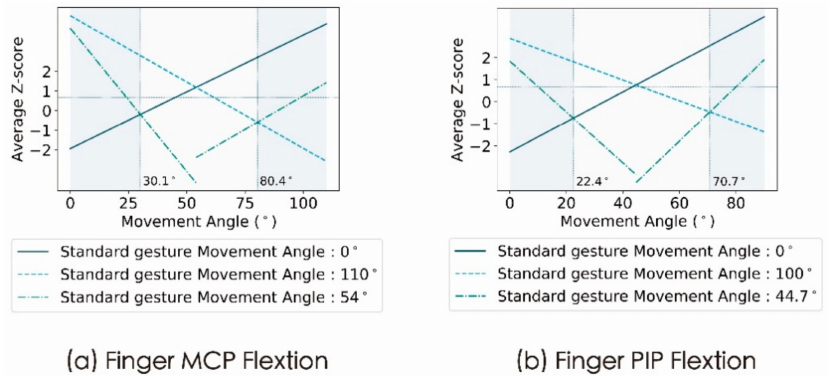
Figure 8. The semantic difference change curve of the contrast gesture under the median and boundary gestures. The reference line with the ordinate of 0.67 is used as the difference boundary. It is generally believed that, when the average Z score exceeds 0.67, the contrast stimulus and the standard stimulus have a perception difference [38]. Moreover, the reference line corresponding to the abscissa marks the intersection between the curves under the median gesture and the curves under the boundary